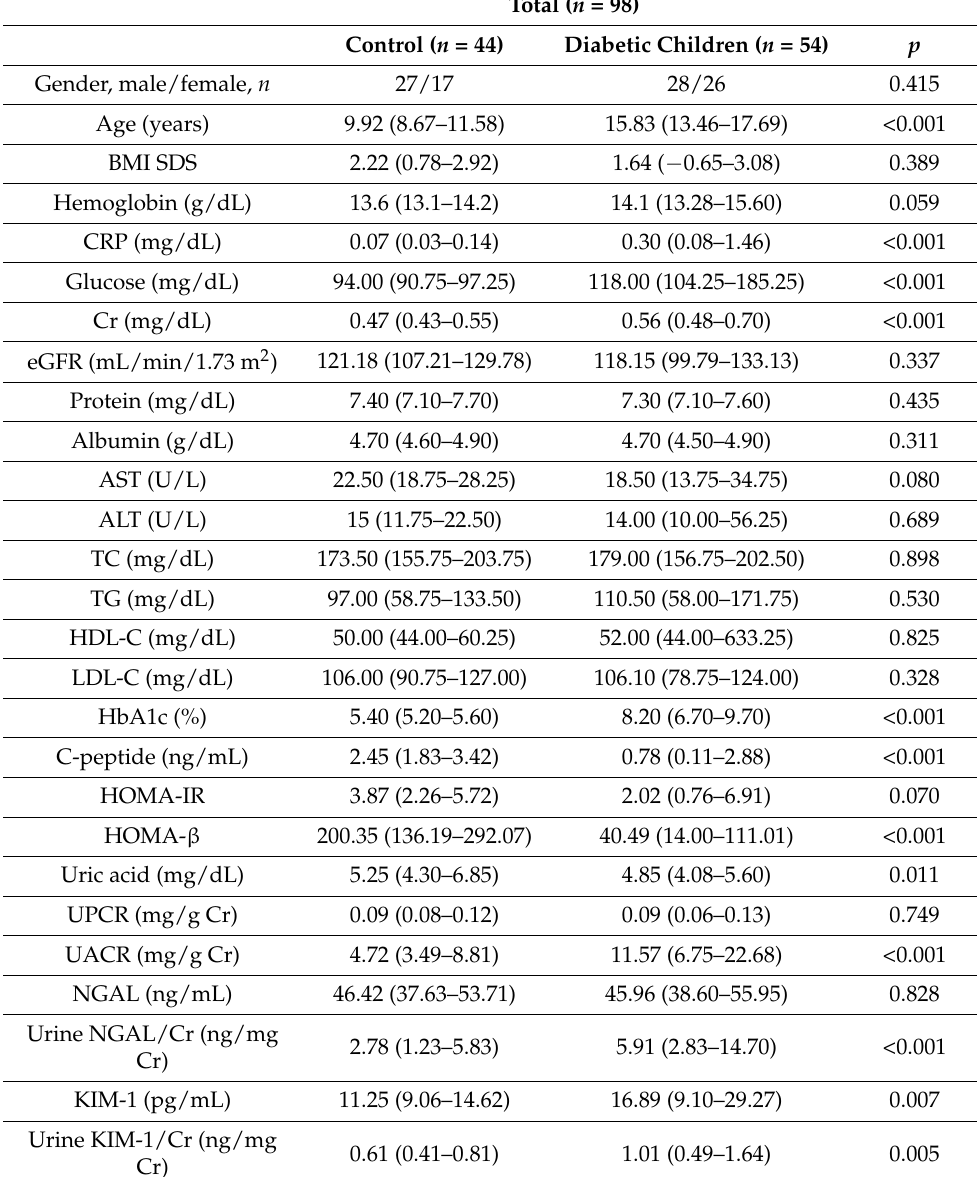
Table 1. Clinical characteristics and plasma and urine biomarker measurements of the study